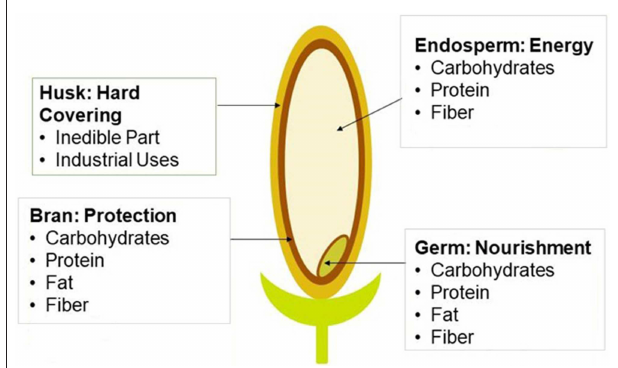
FIGURE 1 | Diagram of a rice kernel. Shows the four different parts of a rice kernel, the rice husk, rice bran, rice germ, and the rice endosperm. Also shows the nutritional content inside different parts of the kernel ( Smith,